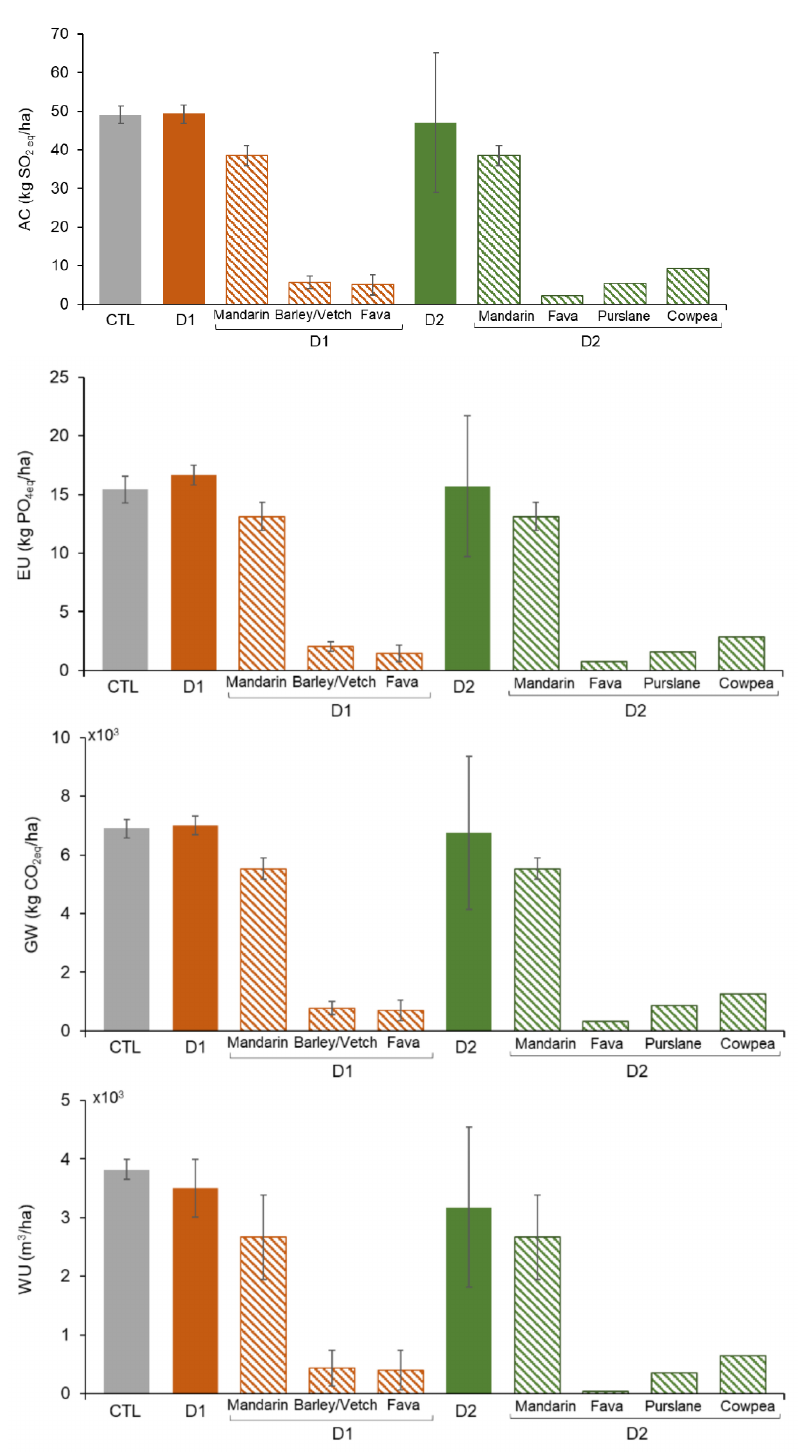
Figure 3. Mean value and standard deviation of the environmental impact indicators per unit of area. The bars with solid patterns present the total values per hectare of cultivated area for mandarin monoculture (CTL), diversification 1 (D1), and diversification 2 (D2). The bars with diagonal line patterns correspond to the disaggregated values for each crop in D1 and D2. Impact categories: Abiotic depletion elements (ADe); Abiotic depletion fossil fuels (ADf); Acidification (AC); Eutrophication (EU); Global warming (GW); and Water use